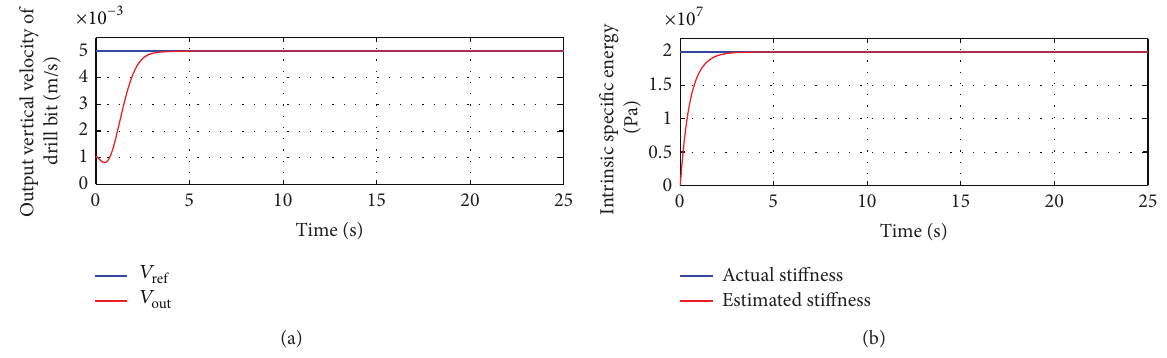
Figure 5: Response of the vertical velocity V (𝑡) (a) and the intrinsic specific energy estimate ̂𝜖(𝑡) (b) for 𝑊 0 = 5000 N, 𝜖 = 20 MPa, and = 5 ⋅ 10 9 . 𝛾 0